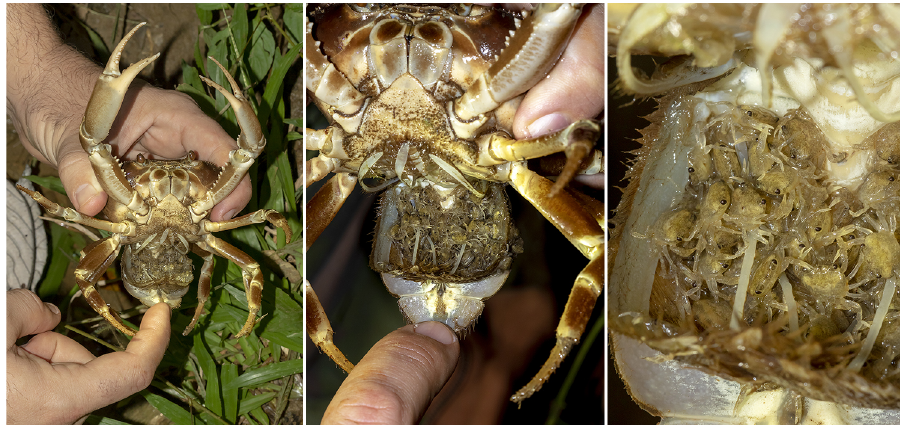
Figure 12 . Female of Epilobocera cubensis poliorcetes found carrying offspring at night on 7 November 2018 on a mountain path about 700 m NW of Jarico ranger station, Lomas de Banao Ecological Reserve, Sancti Spíritus province. Photos by Aslam I.